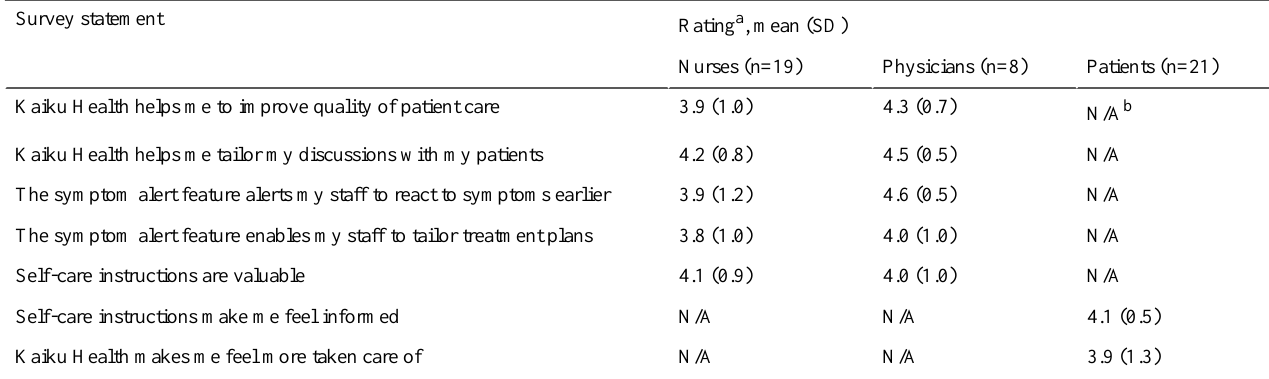
Table 3. Effect of the digital patient monitoring and management tool on quality of patient care for end-of-study survey respondents.